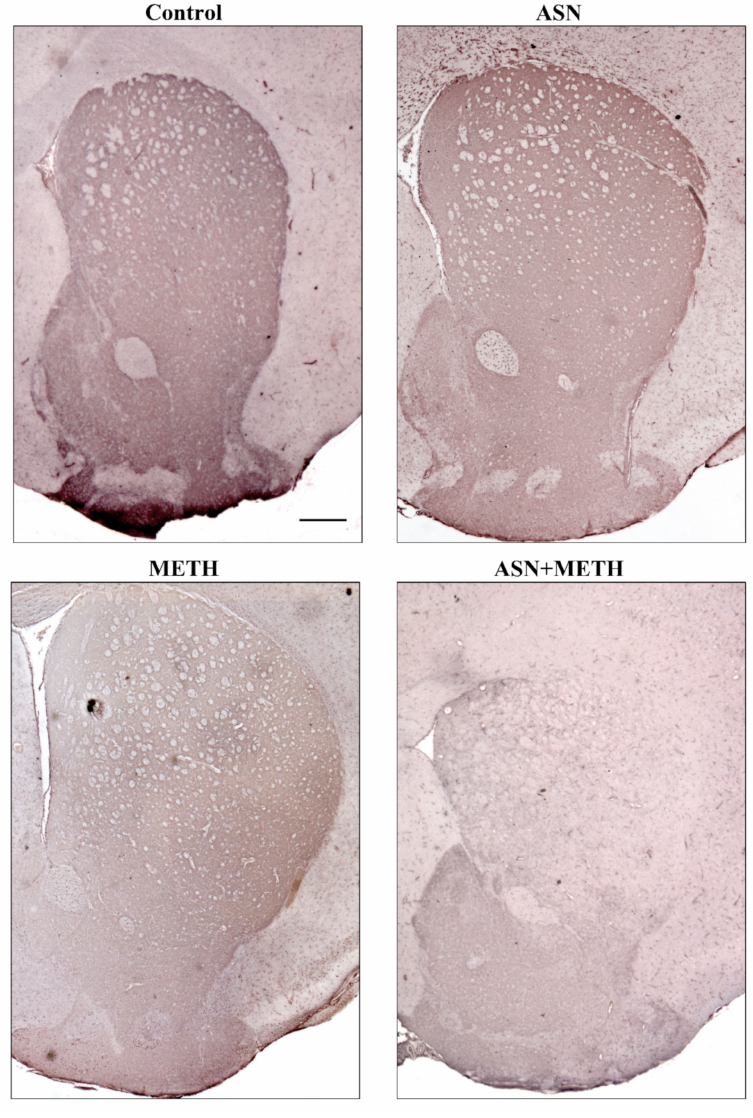
Figure 4. ASN administration worsens METH-induced striatal loss of TH immunostaining. Rep- resentative pictures of TH immunohistochemistry within the striatum in a Control mouse and a mouse administered either ASN (1000 mg/kg × 4), or METH (5 mg/kg × 4), or combined ASN (1000 mg/kg × 4) + METH (5 mg/kg × 4). Scale bar = 380 µ